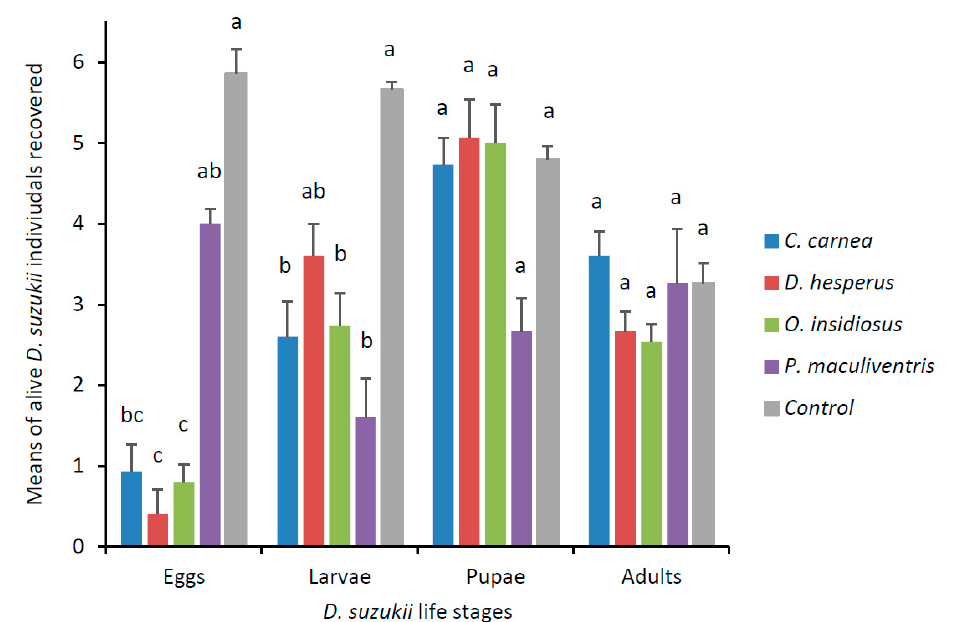
Figure 3. Mean (± SEM) number of D. suzukii life stages recovered after 24-h exposure to predators (either larval C. carnea , adult D. hesperus , adult O. insidiosus or nymph P. maculiventris ). Each arena ( n = 15 per predator species) contained six D. suzukii (either eggs, larvae, pupae or adults) and one predator. Means for each life stages with the same letter were not significantly different (Kruskal–Wallis post-hoc Dunn’s test, p <